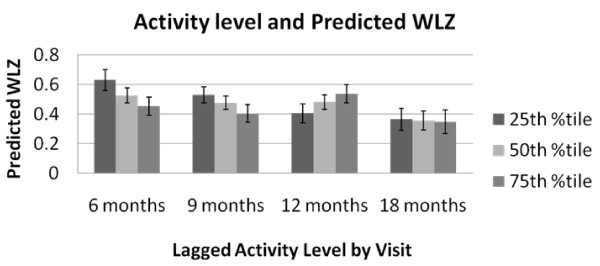
Predicted Weight-for-length Z-score by lagged 25th, 50th, and 75th percentiles of Activity* Level and infant age. * Activity level subscale from the Infant Behavior Questionnaire-Revised.